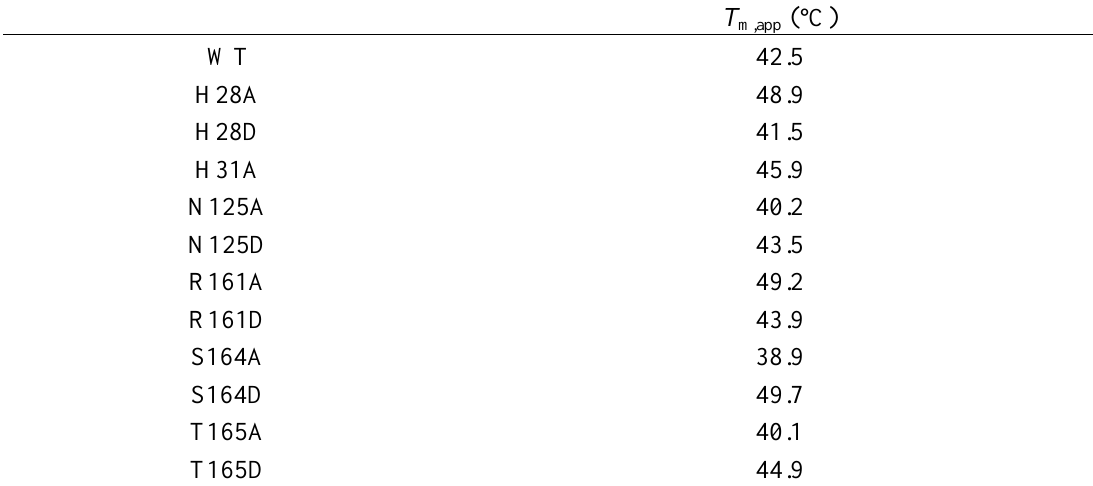
Table S1. T for the different Ca FADS forms obtained by DSC in 20 mM PIPES, m,app 10 mM MgCl , pH 7.0. Estimated errors in T were considered within ±0.3–0.5 °C, this 2 m,app value taken being larger than the standard deviation between three independent experiments and the numerical error after fitting the analysis of each experiment.